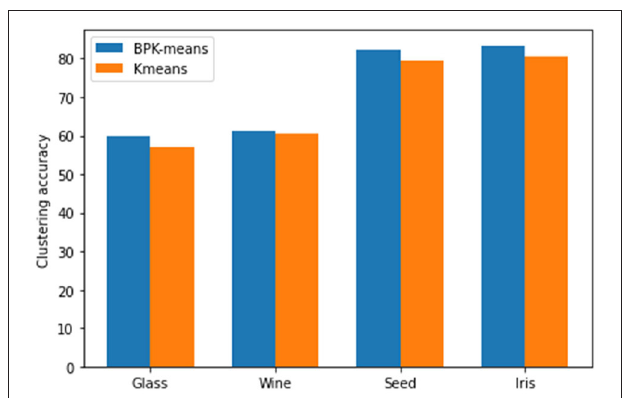
FIGURE 8 | Comparison chart of clustering effect of different data sets.